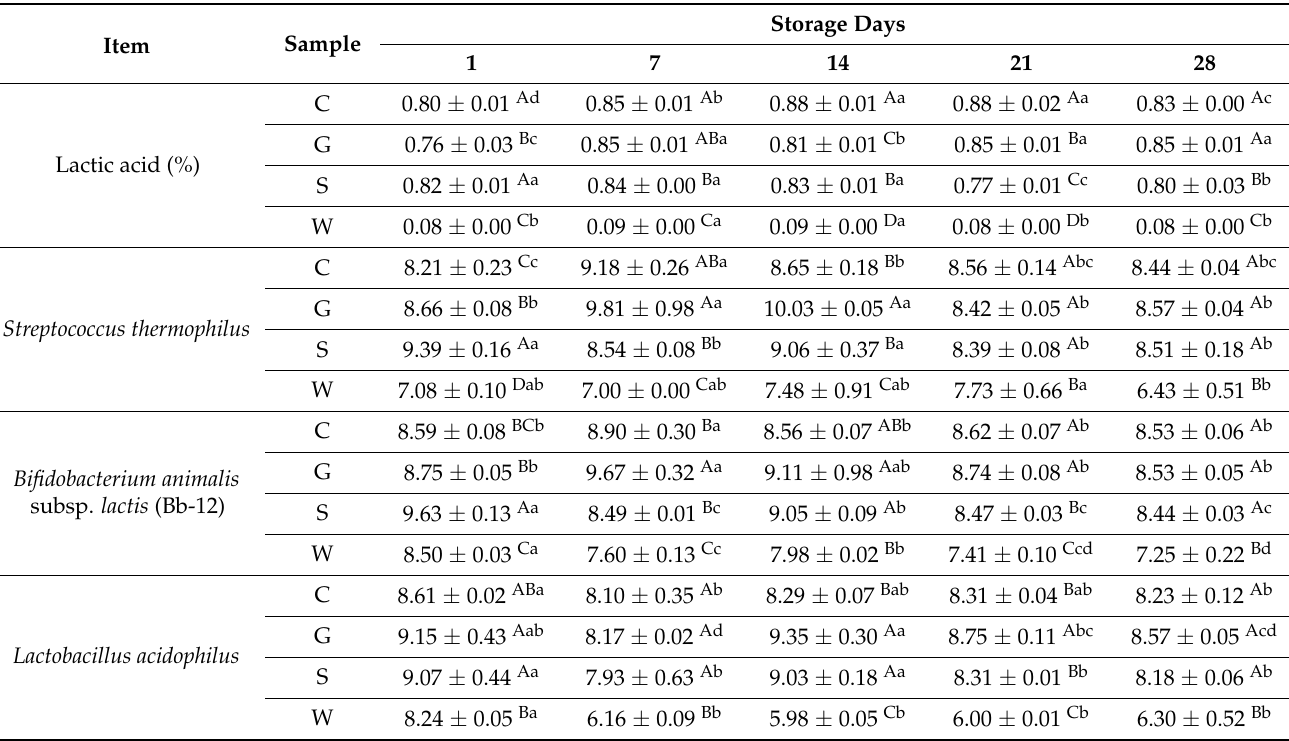
Table 1. Lactic acid (%) and viable bacteria count (log CFU/mL) changes in probiotic fermented whey beverages enriched with kiwi powder during